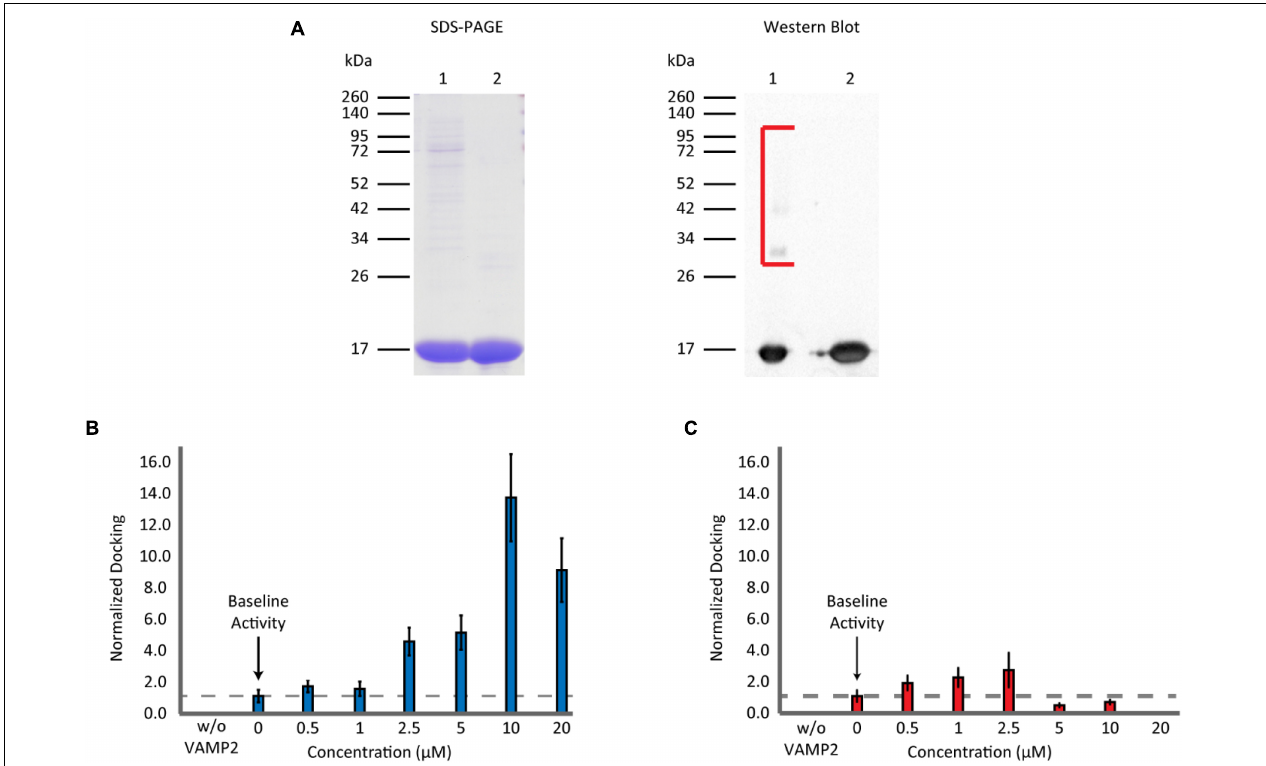
FIGURE 2 | Non-aggregated α S enhances vesicle docking activity even at excessive concentrations. (A) SDS-PAGE and western blot analysis of purified recombinant α S. A 12% SDS-PAGE gel containing α S through the two rounds of gel filtration: Lane 1 contains α S after the 1st round of gel filtration. Lane 2 contains α S after the 2nd round of gel filtration (left panel). A western blot of α S through the two rounds of gel filtration (right panel). The lane order is the same as SDS-PAGE. Bracket encloses higher molecular weight α S bands observed only in the sample from a single round of gel filtration. (B) Analysis of vesicle docking with twice purified α S (lane 2 in A). The number of docking events for each α S concentration is normalized relative to that without α S. The dashed line represents the vesicle docking activity of SNAREs without α S. Studies without VAMP2 were done by flowing v-liposomes without VAMP2 reconstituted in them along with 10 µ M α S over the supported t-bilayer. No events were observed. In total 3,148 docking events from 82 independent measurements are analyzed. (C) Analysis of vesicle docking with one-time purified α S (lane 1 in A). The number of docking events from each α S concentration is normalized with respect to those without α S. The dashed line represents the docking activity of SNAREs without α S. Studies without VAMP2 were done in the same way as in B. A total of 6,249 vesicle docking events from 65 independent measurements are